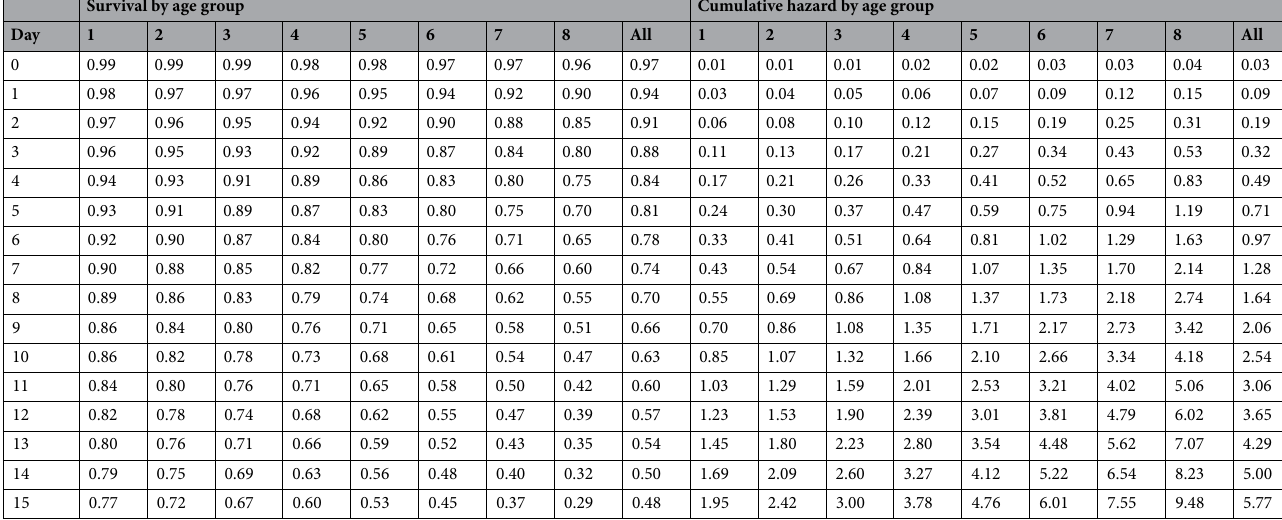
Table 5. ICU survival and hazard by age group. Note: 1: 0–17, 2: 18–29, 3: 30–39, 4: 40–49, 5: 50–64, 6: 65–74, 7: 75–84, and 8: ≥ 85